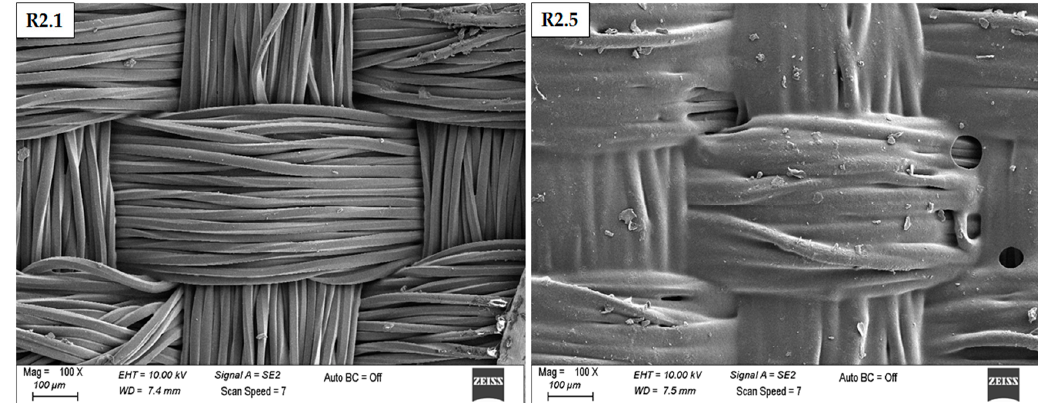
Figure 6. SEM images of reference fabrics for 0.1 and 0.5 mm coating thicknesses (Magnification: 100×).